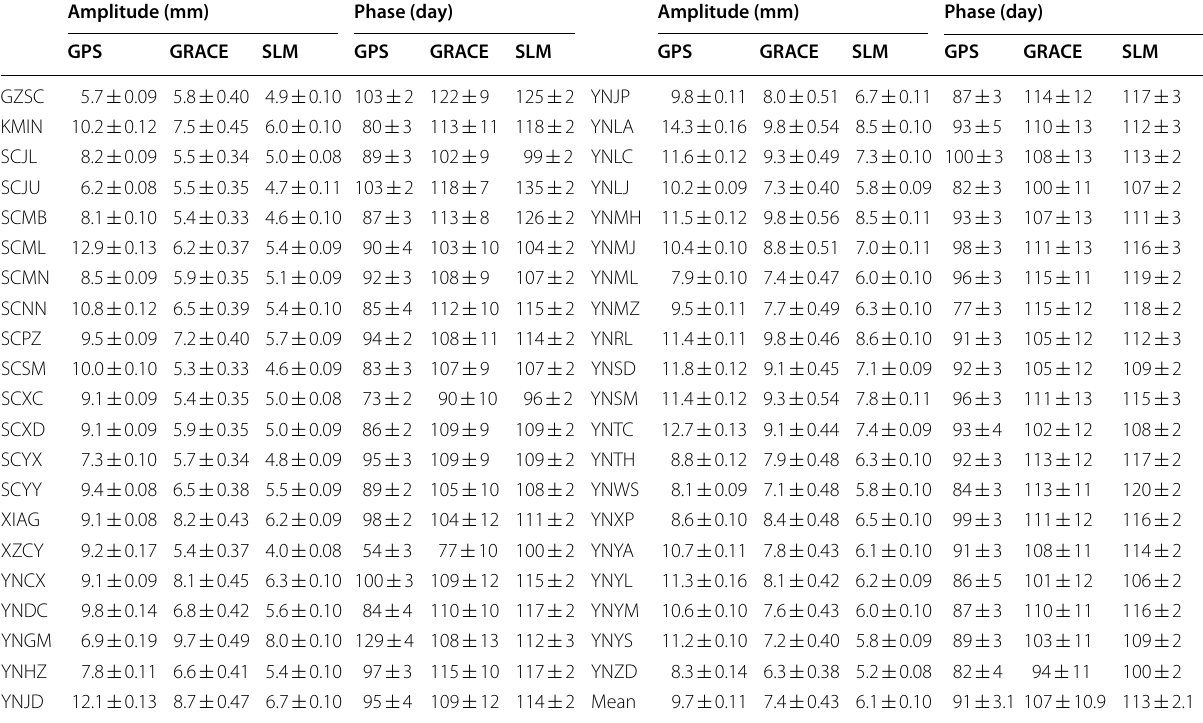
Table 1 Annual amplitude and phase estimated by GPS, GRACE, and surface loading model